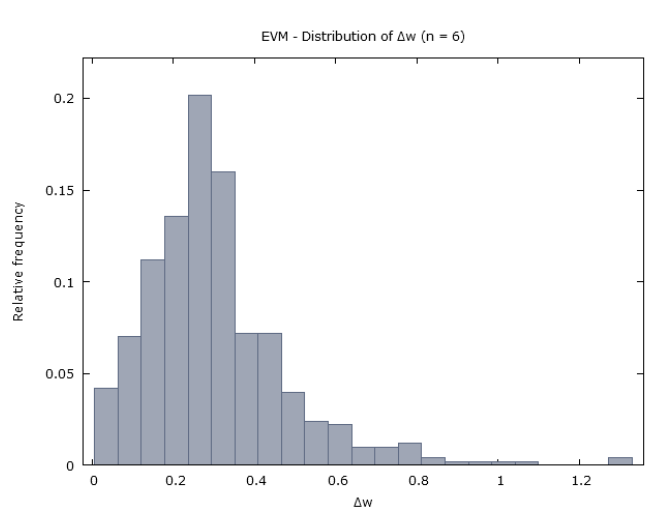
Figure 9. Sensitivity of the EVM: frequency distribution, n =